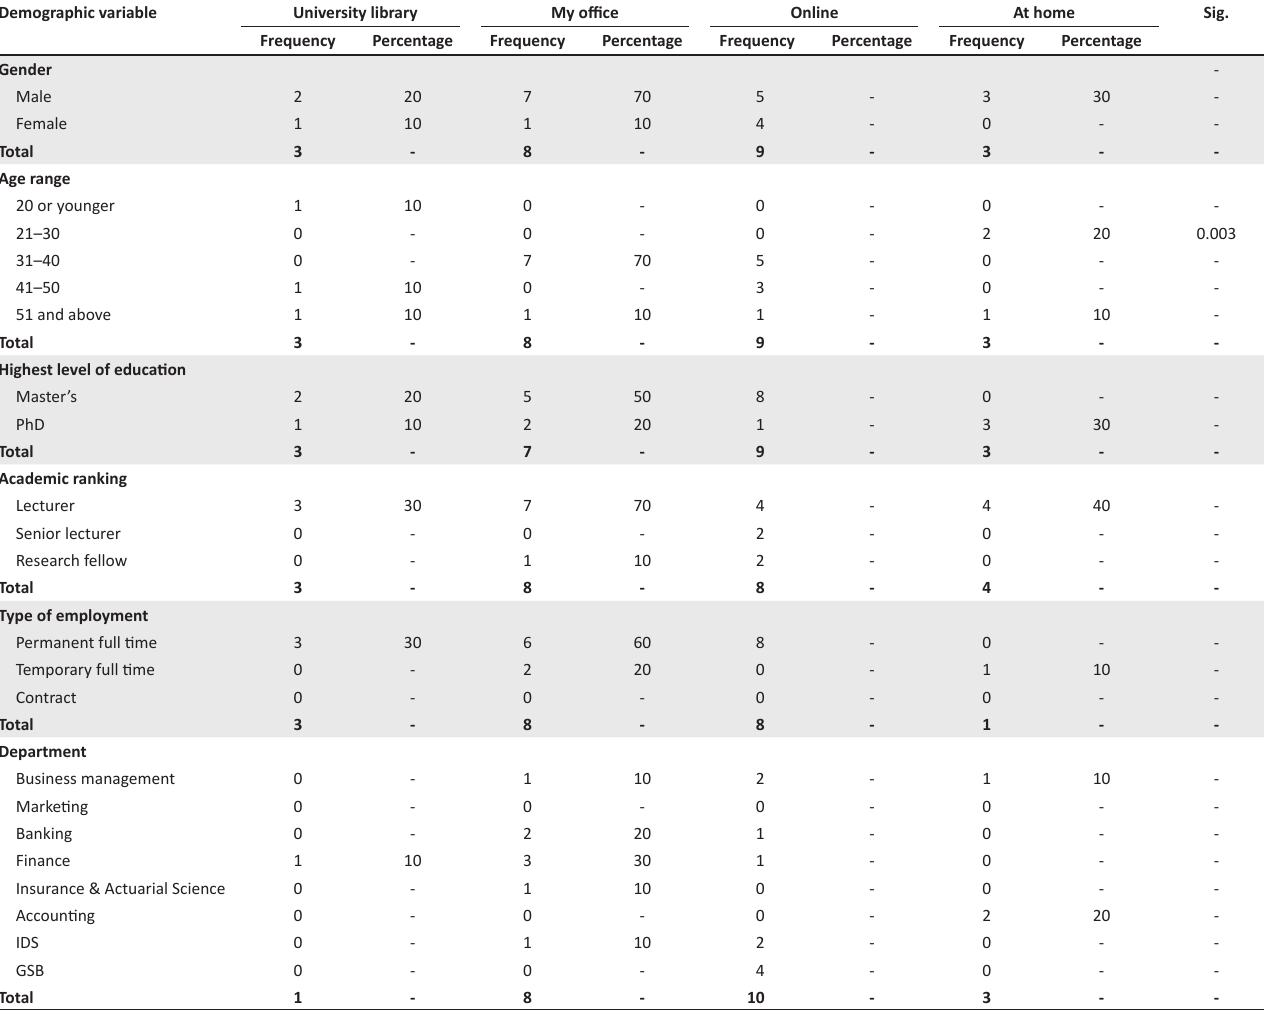
TABLE 5: Location of research studies by respondents who did not convey their results ( N = 10). Demographic